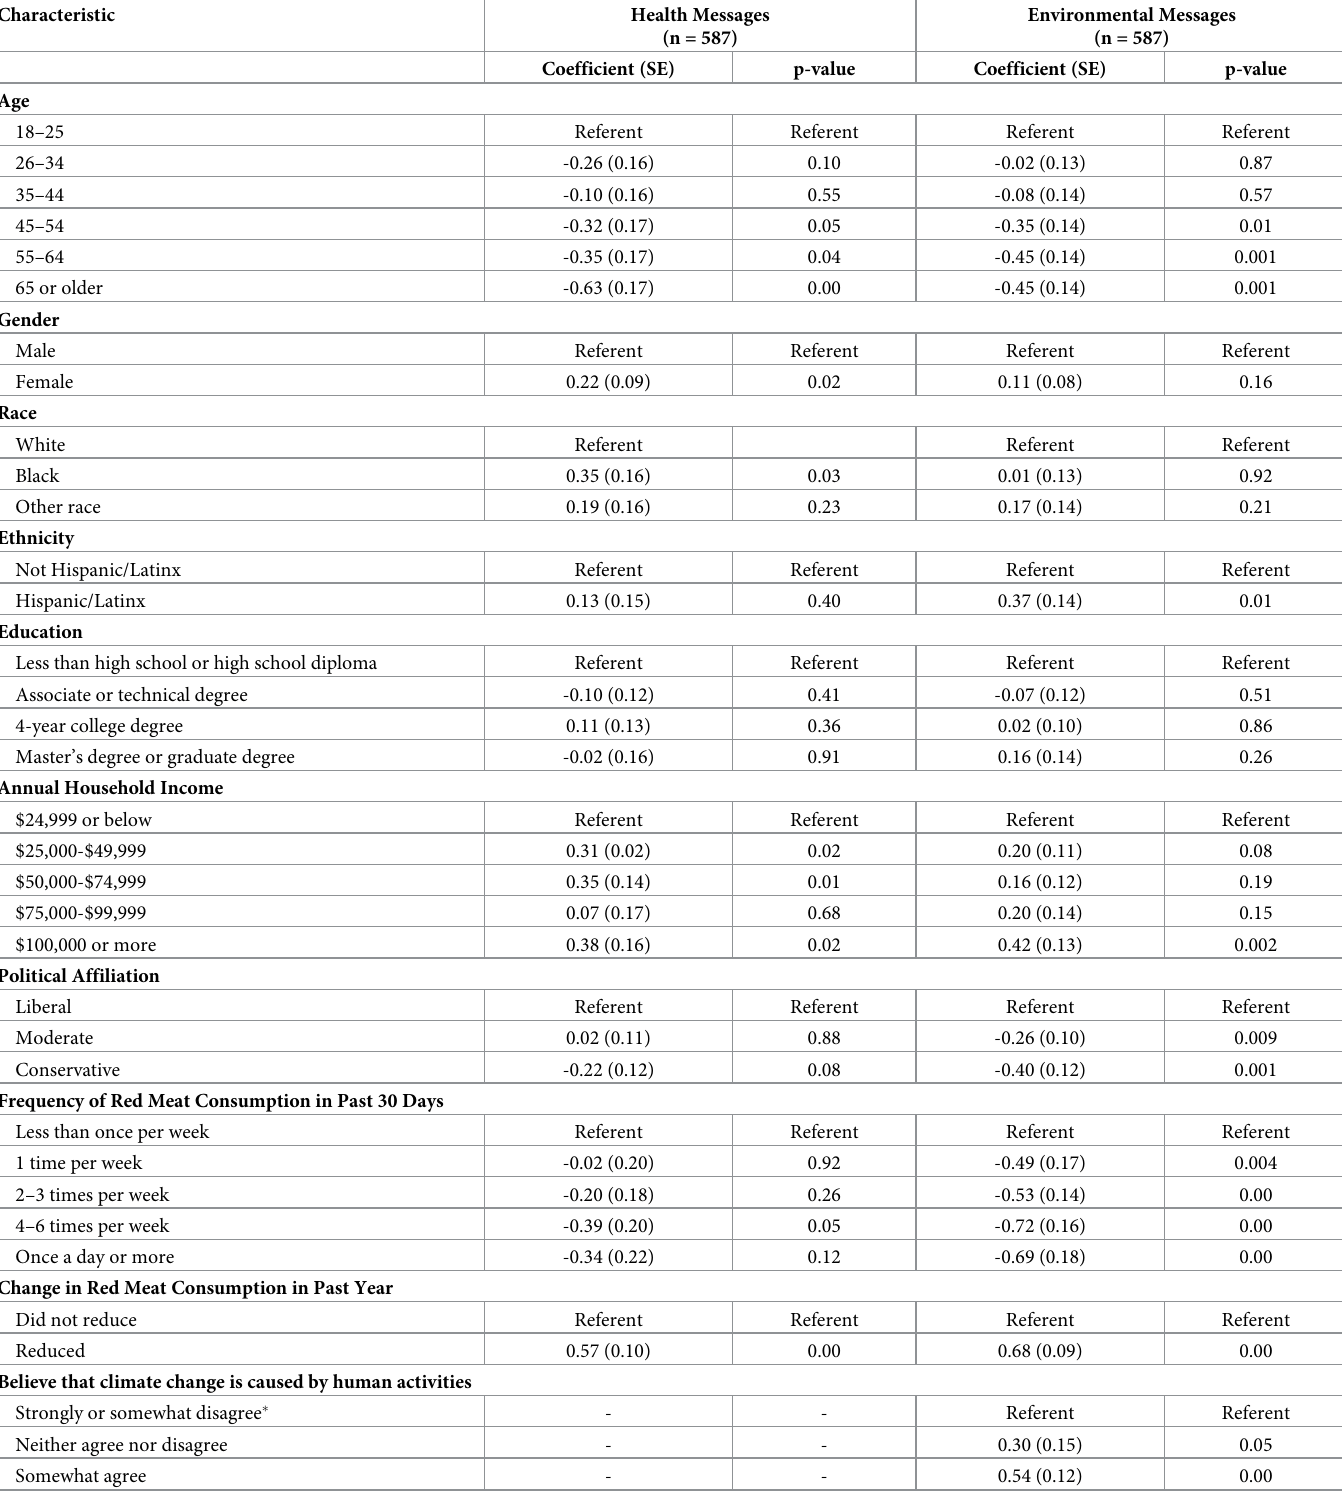
Table 6. Results of linear regression of demographic and behavioral characteristics and perceived message effectiveness (PME) of health (n = 587) and environmen- tal messages (n =